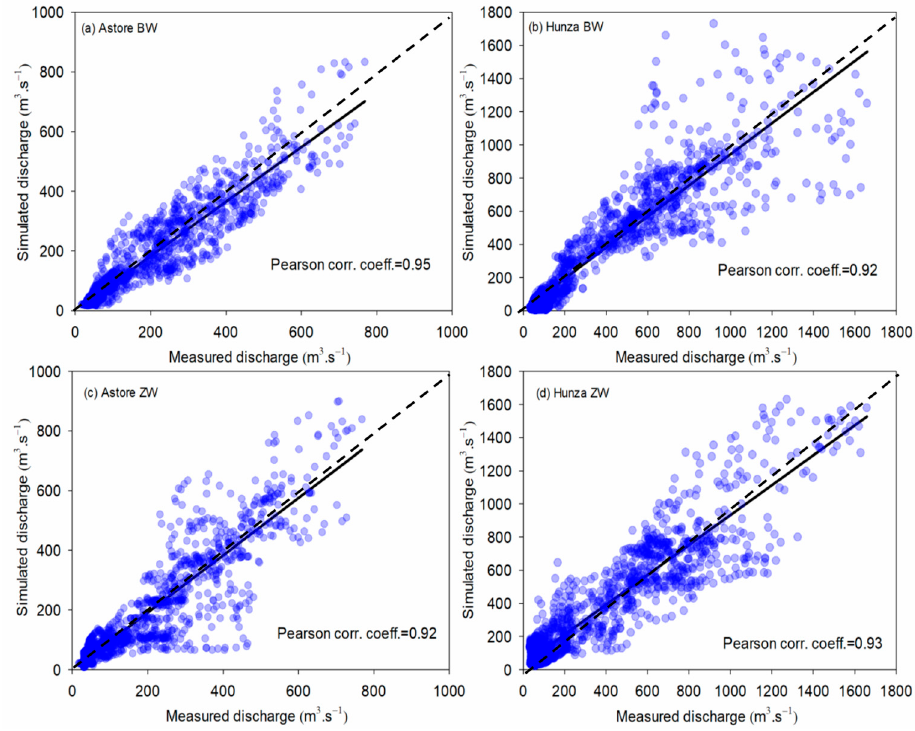
Figure 5. Correlation between observed and simulated discharge (Q) is presented in ( a ) and ( b ) panels for the basin-wide application and ( c ) and ( d ) panels for the zone-wise application of SRM in the Astore and Hunza basins over study period (2000–2004). The solid and dash lines represent regression lines and 1:1 lines respectively.